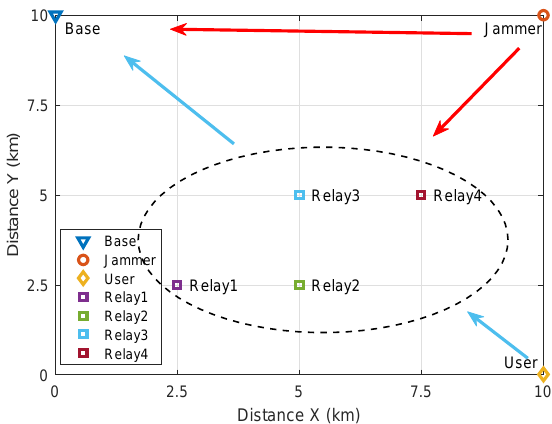
Figure 3. Location of base station (BS), the user, jammer and relay group.